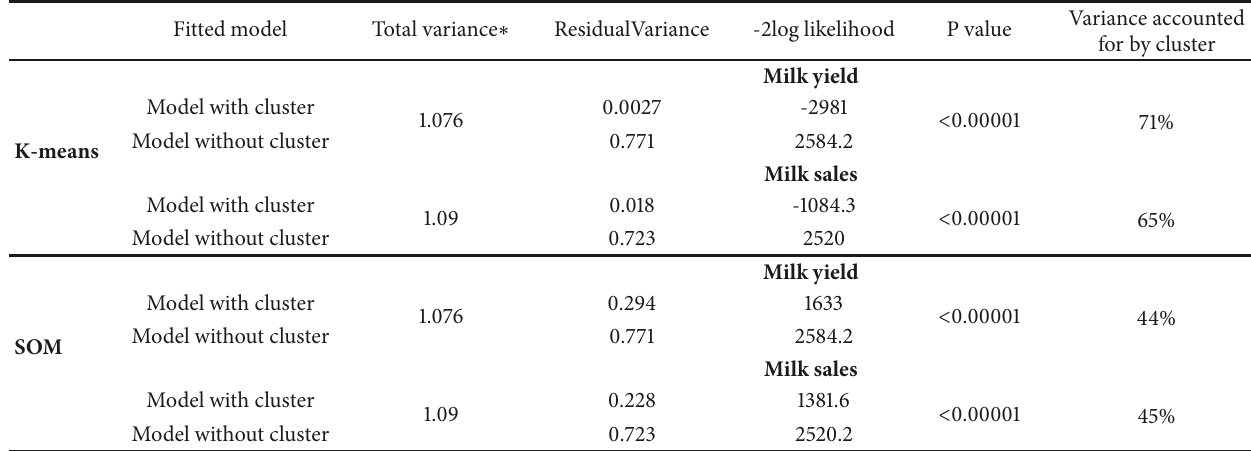
Table 11: Proportion of variances accounted for by cluster of production in